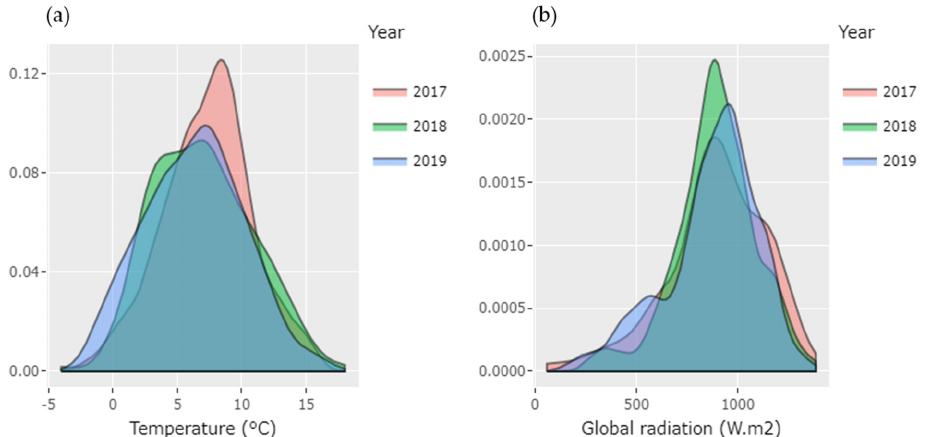
Figure 1. Minimum Temperature in °C ( a ) and maximum UV solar radiation/day (W m − 2 ) ( b ) during three consecutive years (2017–2019) of the experimental period with calafate berries in Coyhaique.